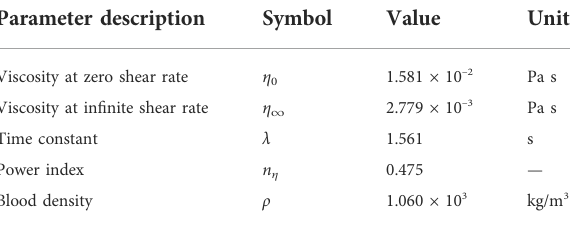
TABLE 2 Values of model parameters ofthe rheological and thrombus models.